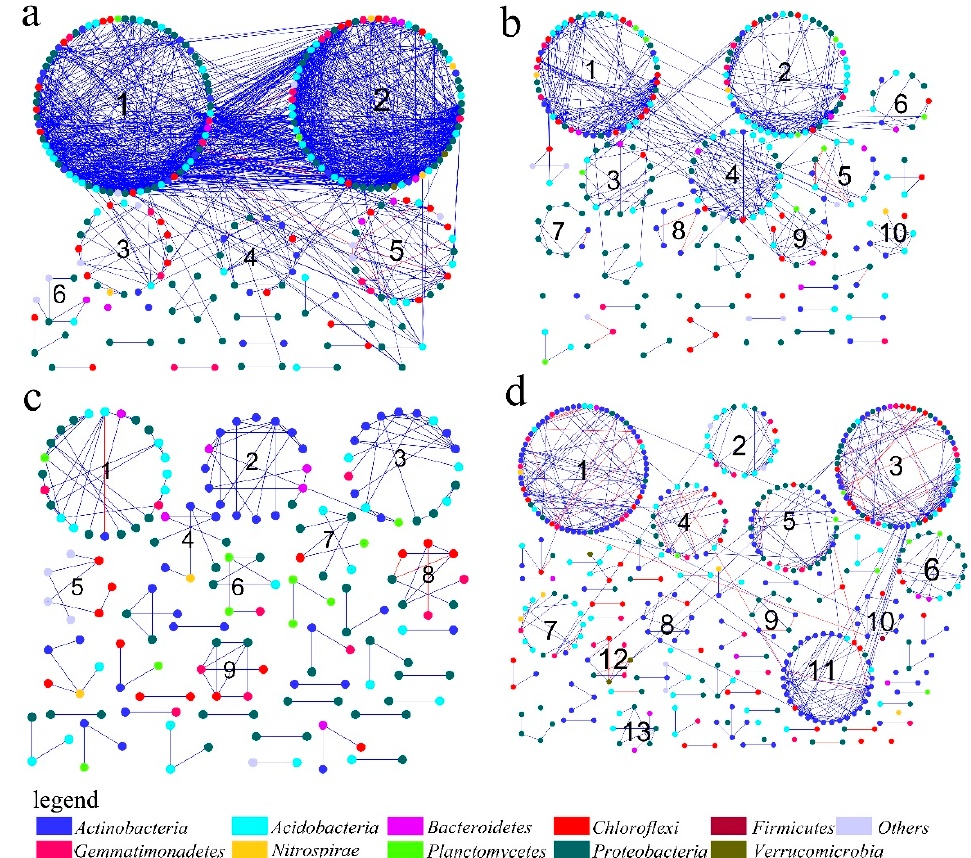
Figure 6. Network graph with module structure produced by the fast-greedy modularity optimization method. Each node corresponds to a microbial population. Arable numbers such as 1, 2, 3, and 4 stands for the module number. A red link indicates a negative correlation, and a blue link indicates a positive correlation. ( a ), ( b ), ( c ) , and ( d ) stand for the PB, ZC, YQ, and DT network, respectively.